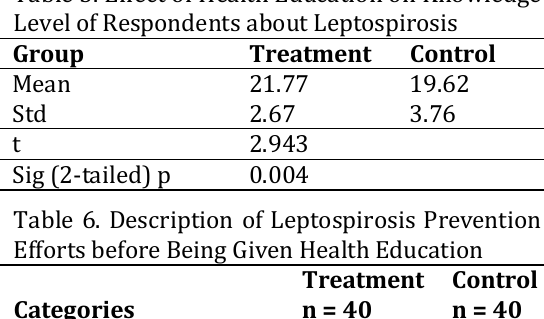
Table 5. Effect of Health Education on Knowledge